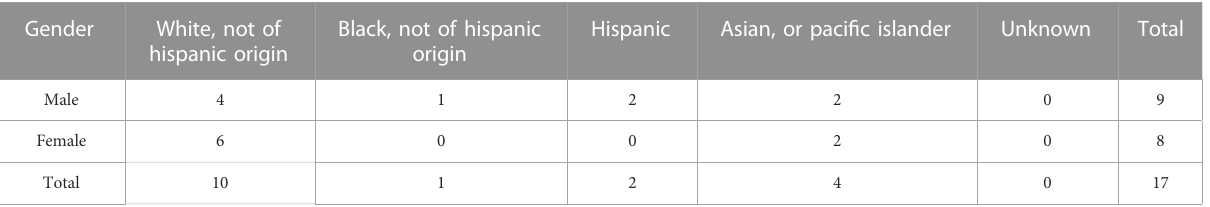
TABLE 1 Patients enrolled in studies 1 and 2, according to race and gender.